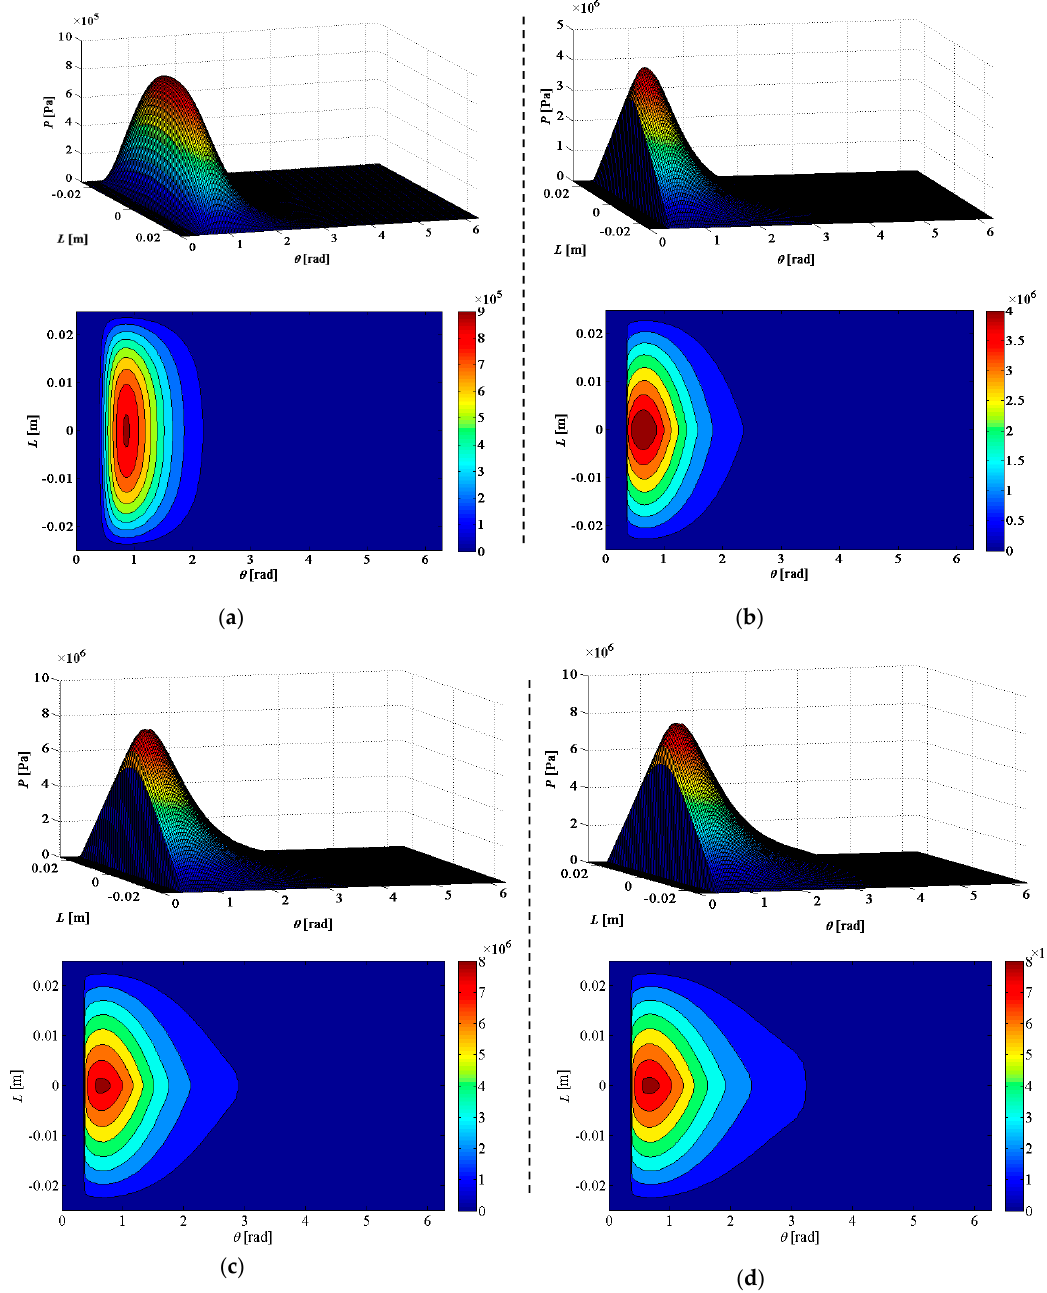
Figure 9. Three-dimensional graphs and contour maps of the film pressure distribution under several